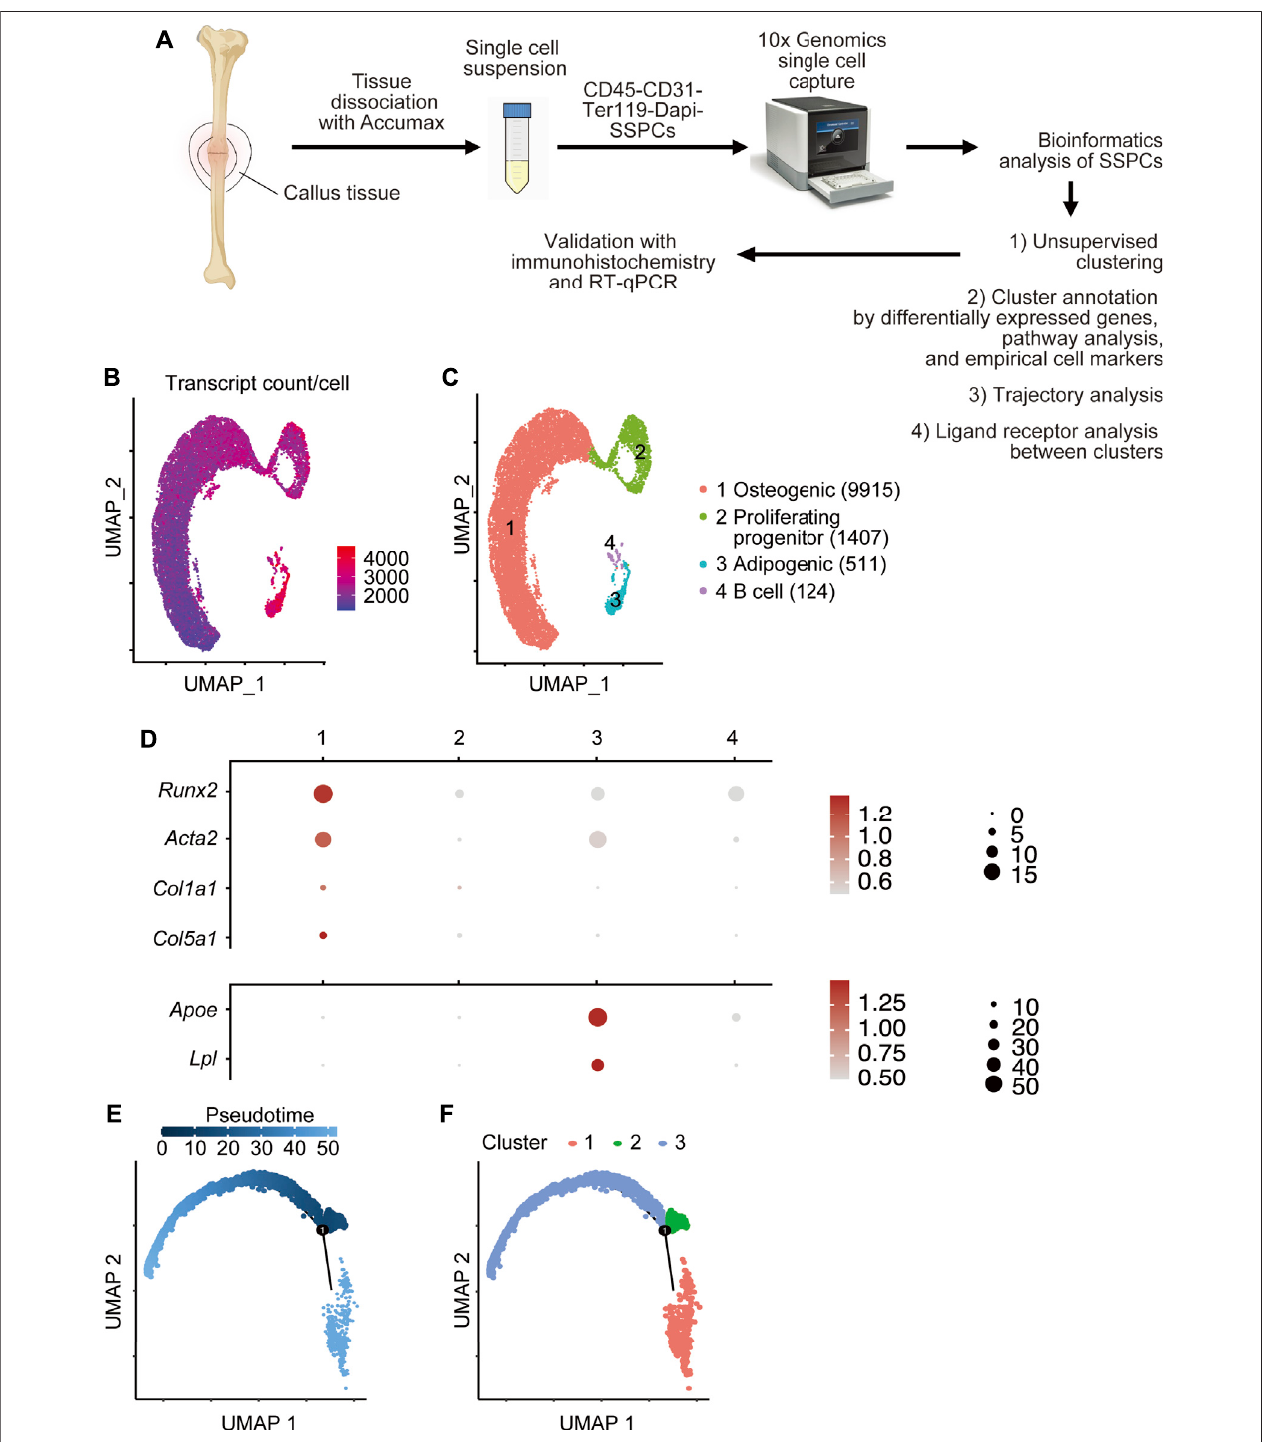
FIGURE 1 | Single-cell RNAsequencingoffracturecallusCD45 - CD31 - Ter119 - SSPCcells. (A) IsolationofcallusSSPCsforscRNAseq.Thetibialfracturewasperformedon4- month- (young) and 21-month-old (aged) C57BL/6J male mice, and fracture callus was harvested 10 days after the procedure. A single-cell suspension was prepared by pooling two fracture calluses. CD45 - CD31 - Ter119 - Dapi - SSPC cells were sorted with FACS and subjected to scRNAseq. Data were analyzed using bioinformatics methods and validated by immunohistochemistryandRT-qPCR. (B) ThenumberoftranscriptspercellisdemonstratedonUMAP. (C) Atotalof11,957cellsweresubjectedtounsupervisedSNNclustering usingSeurat/Randresolvedfourmajorclusters.Thenumberofcellswithineachclusterisindicatedinthe fi gurelegend:9,915cellsintheosteogeniccluster,1,407cellsintheproliferating progenitorcluster,511cellsintheadipogeniccluster,and124cellsintheBcellcluster. (D) ExpressionofputativeosteogenicandadipogenicmarkersofSSPCsinclusters1 – 3: Acta2 (SSPC), Runx2 (osteogenic), Col1a1 and Col5a1 (osteoblast), and Apoe and Lpl (adipocyte). (E,F) Pseudotime analysis of cluster 1 – 3 with Monocle2 demonstrating that cluster2 proliferatingprogenitorwastheearliestalongthedevelopmentaltreeaccordingtopseudotimealignmentandcoulddifferentiateintocluster1osteogeniccellsandcluster3adipogeniccells.